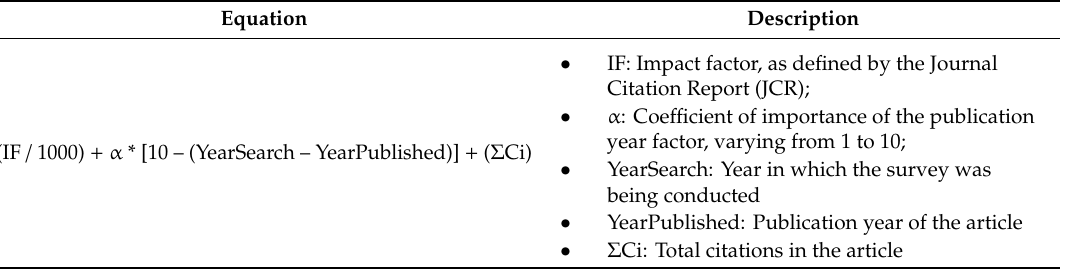
Table 1. Description of the equation used to calculate the InOrdinatio